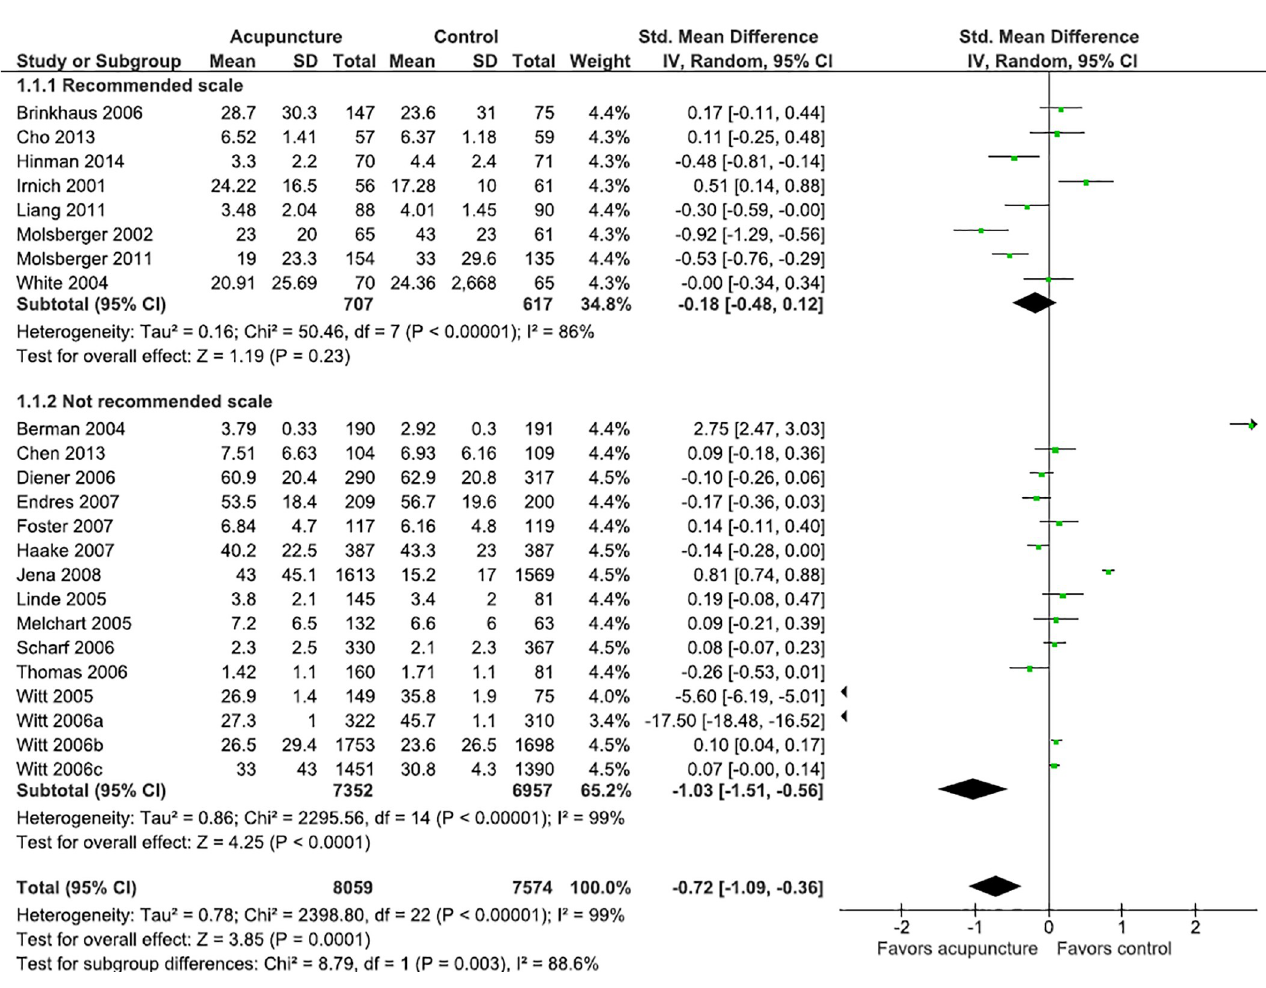
Fig 3. Meta-analysis of the effect of acupuncture on pain stratified by the use of recommended scale or not.